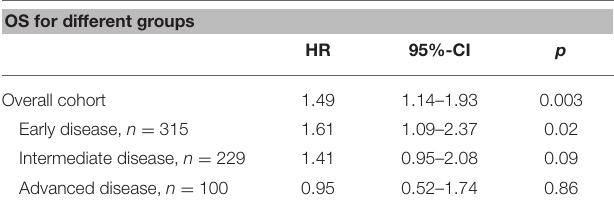
TABLE 1 | Hazard ratios of OS for 9/10 compared to 10/10 for different disease